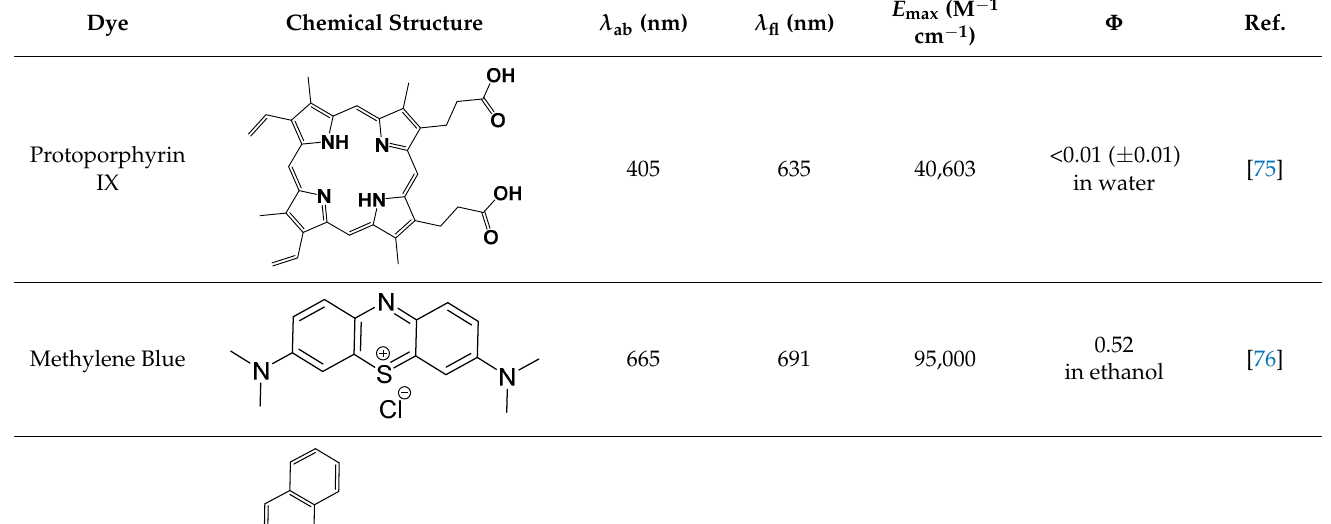
Table 1. Representative examples and the physical properties of chromophores with photoacoustic properties that have been used within cancer theranostics. The name of the chromophore, its chemical structure, its maximum wavelength of absorption ( λ ab (nm)) and emission ( λ fl (nm)), the molar extinction coefficient ( ε , (M − 1 cm − 1 )), and the fluorescence quantum yield ( Φ ) are presented.